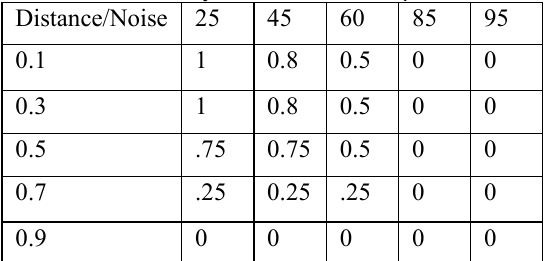
Table 5. considering Distance and Noise the operative Table 6. Fuzzy relation after ˄ operation